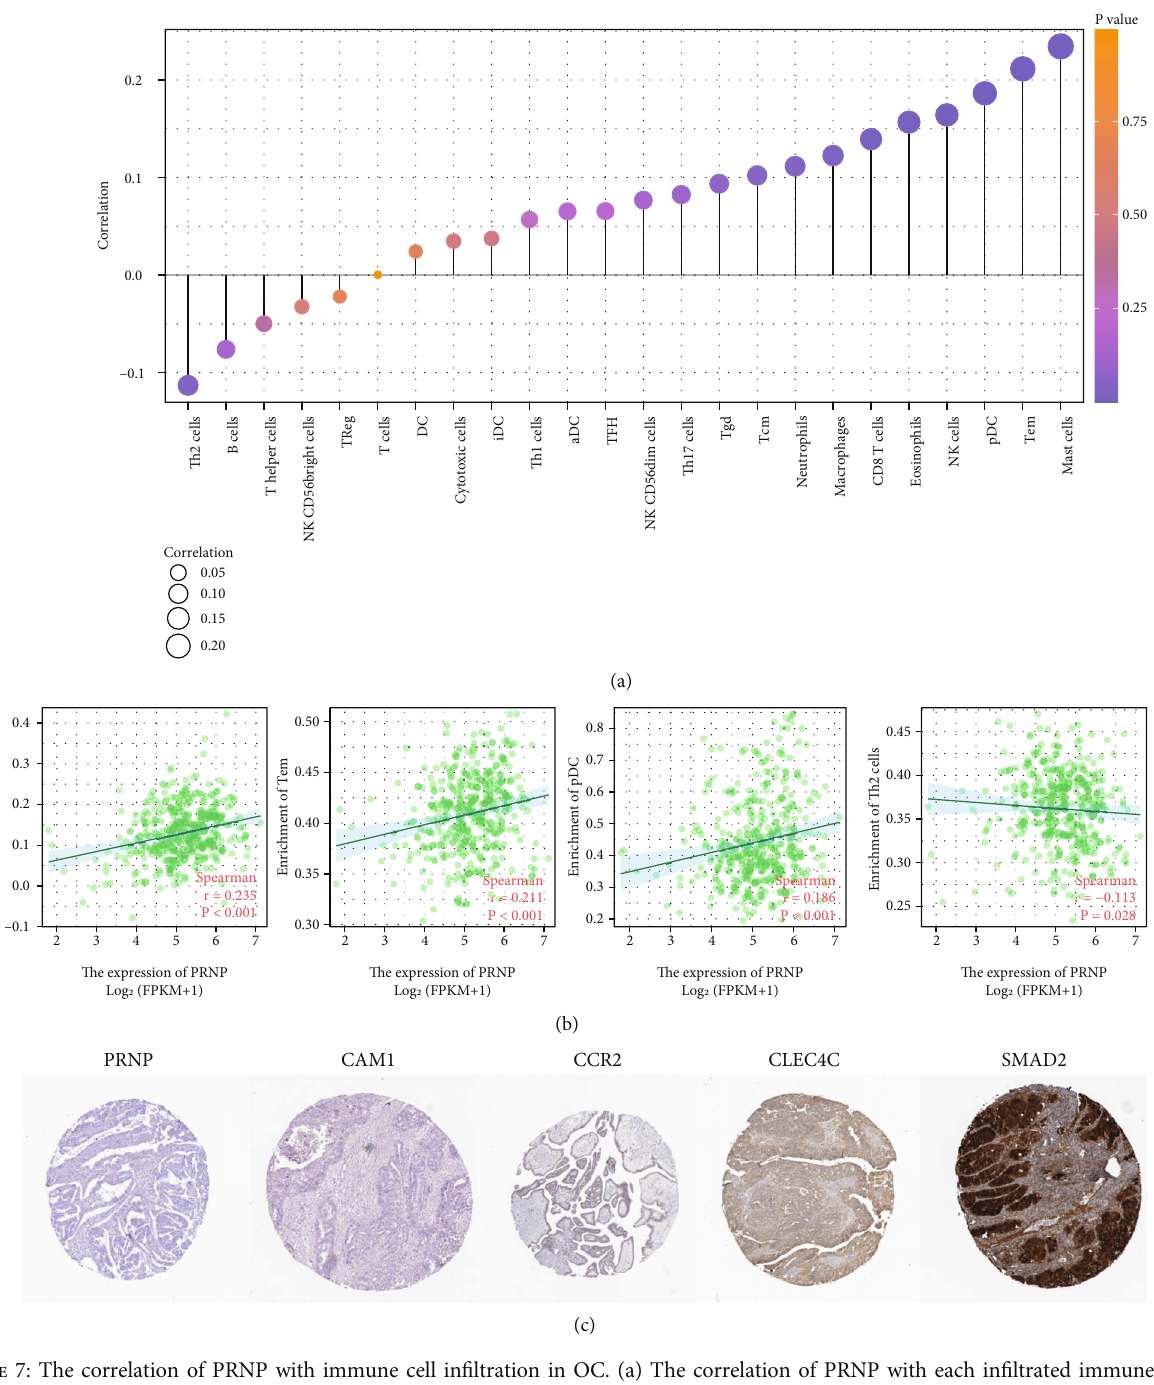
Figure 7: The correlation of PRNP with immune cell in fi ltration in OC. (a) The correlation of PRNP with each in fi ltrated immune cell (Xiantao). (b) The top three immune cells with the highest correlation and the one with the lowest (Xiantao). (c) Immunohistochemistry images showed the protein levels of PRNP and CAM1, CCR2, CLEC4C, and SMAD in OC (The Human Protein Atlas